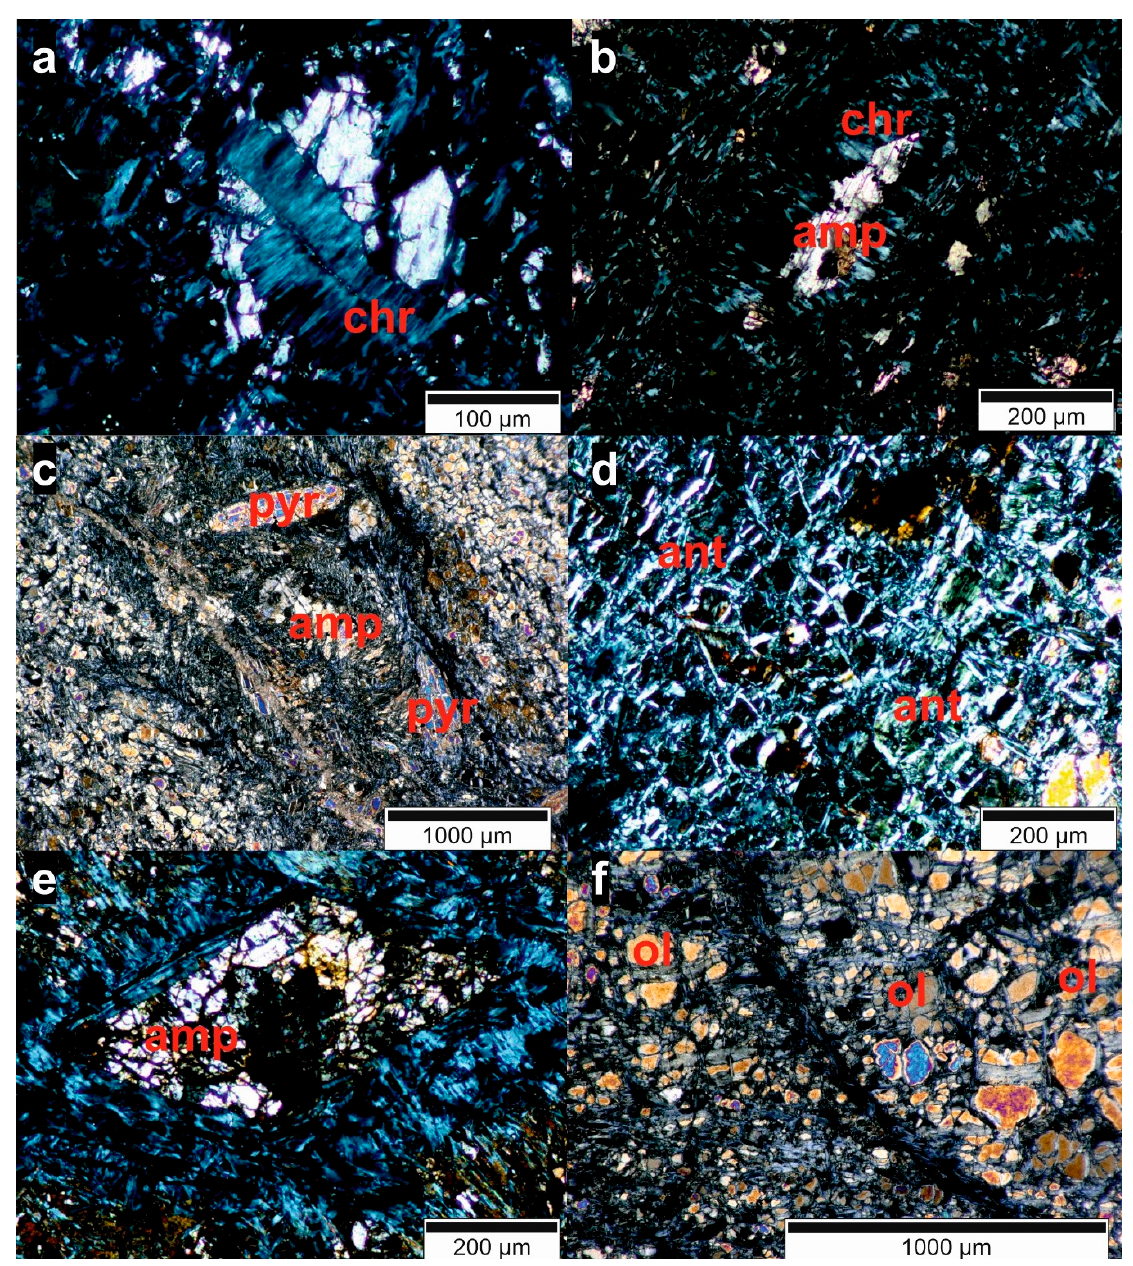
Figure 14. Microscopic photos of the thin sections related to the sample numbers: ( a ) + ( b ) = D-07; ( c ) = D-08.1; ( d ) = D-08.2; ( e ) = D-09; ( f ) = D-10 (ol = olivine, ant = antigorite, chr = chrysotile, pyr = pyroxene, amp = amphibole, chl = chlorite, op = opaque phase) [34].